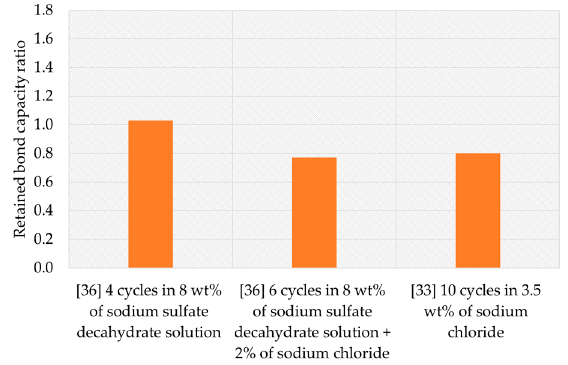
Figure 11. Effect of sulfate and chloride attack on the load-carrying capacity of steel reinforced grout (SRG)–masonry [36] and FRCM–masonry [33] joints.